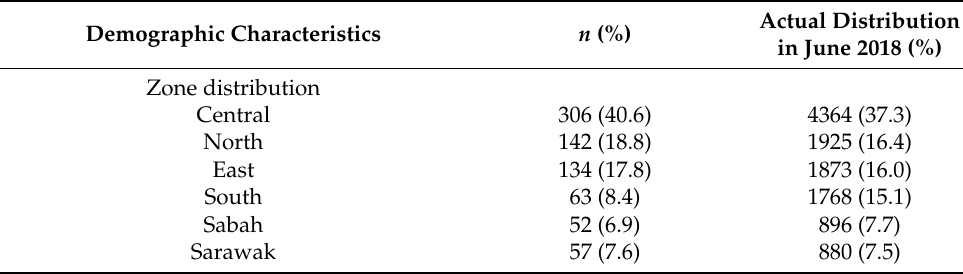
Table 1. Training characteristic, personal demographics and undergraduate training background for the participants enrolled in the study ( n =